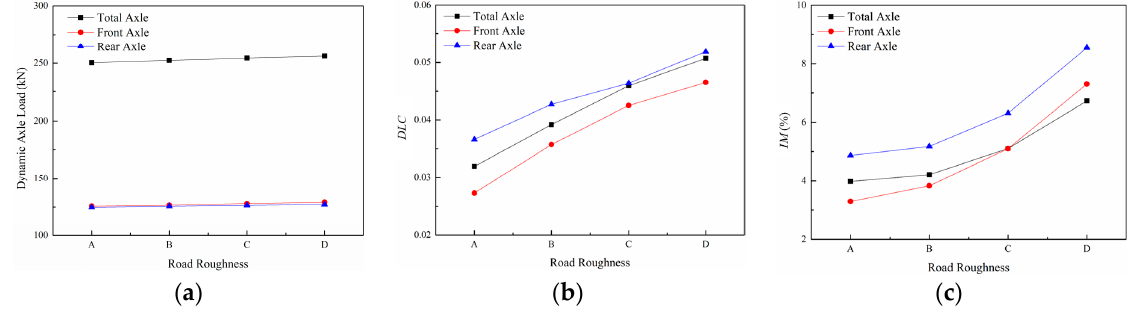
Figure 20. Dynamic axle load in straight road sections with different road roughness under simulation conditions. ( a ) Dynamic axle load. ( b ) DLC . ( c ) IM .